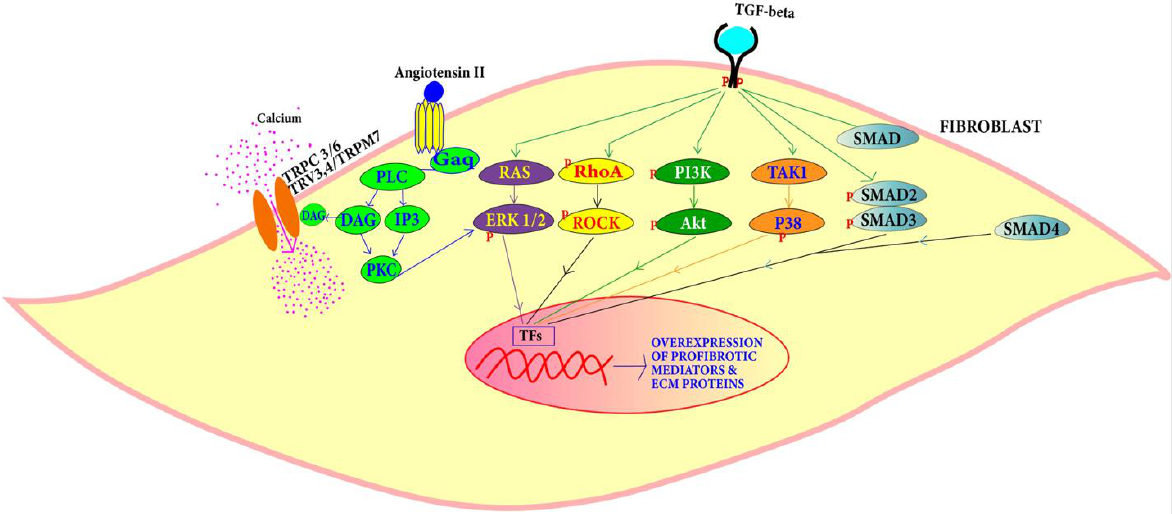
Figure 5. TGF- β can induce cardiac fibroblast proliferation through SMAD -dependent and SMAD- independent pathways, while proliferation through Ang-II is mediated by PLC, DAG, IP3 and PKC. TGF- β Pathway: TGF- β is a signaling molecule that is involved in a plethora of signal- ing pathways. TGF- β can change the expression of extracellular matrix components [88].